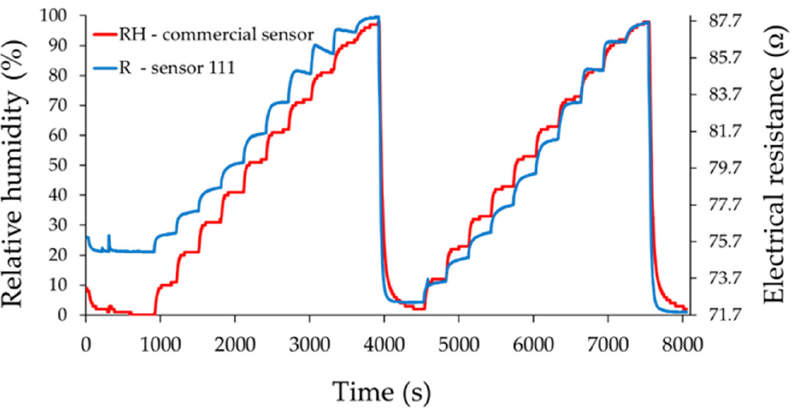
Figure 10. The response of sensor 111 (“R curve”—blue) as a function of time for two measurement cycles, when relative humidity was increased in ten steps from 0% RH to 100% RH; “RH curve—red” shows the similar characteristic measured for a commercial, industrial sensor.